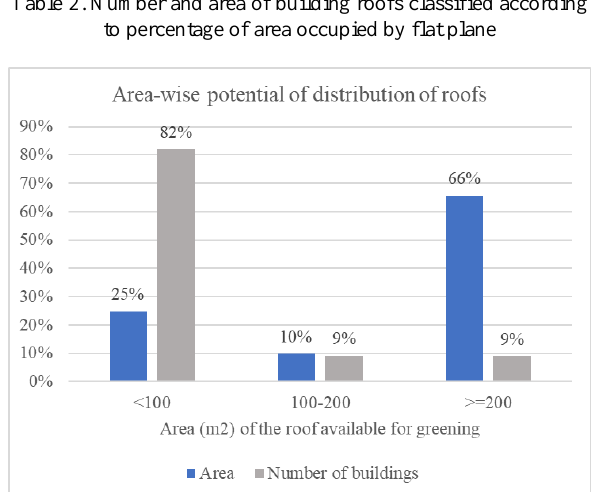
Figure 3. Area-wise percentage of total potential roofs (Area and number of buildings)